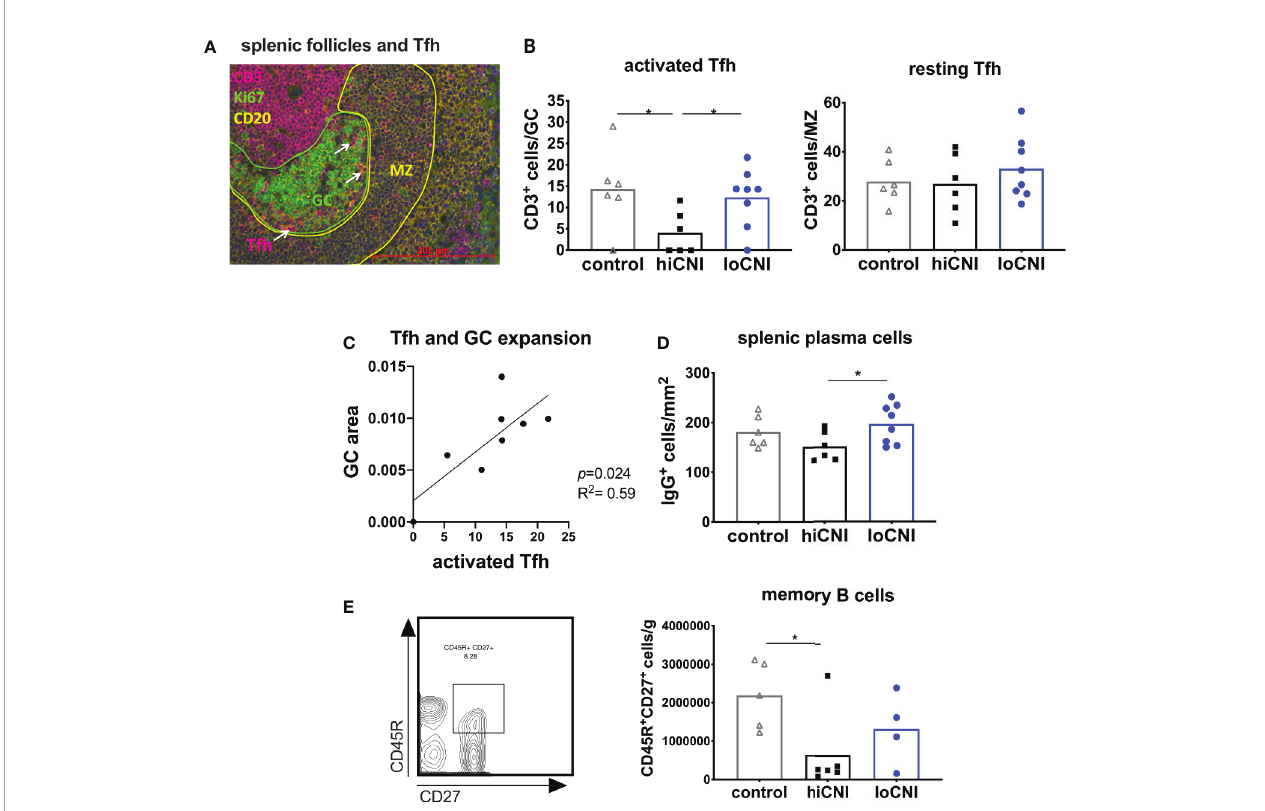
FIGURE 4 | Activated T follicular helper cells drive GC formation. (A) immuno fl uorescence staining of a splenic follicle with T cell zone (CD3 + , red), GC (Ki67 + , circled green), B cell follicle (CD20 + , yellow) with mantle zone (MZ, circled yellow) and Tfh (white arrows). (B) average number of activated Tfh (CD3 + cells in Ki67 + GC area) and resting Tfh (CD3 + cells in CD20 + MZ area) in controls (n=6), hiCNI (n=6) and loCNI (n=8). (C) Correlation of the number of activated Tfh and GC expansion within the loCNI group. (D) plasma cells measured as IgG + cells in spleen sections from controls (n=6), hiCNI (n=6) and loCNI (n=8), and (E) CD45R + CD27 + memory B cells measured by fl ow cytometry in controls (n=5), hiCNI (n=6) and loCNI (n=4). Means and individual data points are shown; statistical signi fi cance between groups is shown as *p ≤